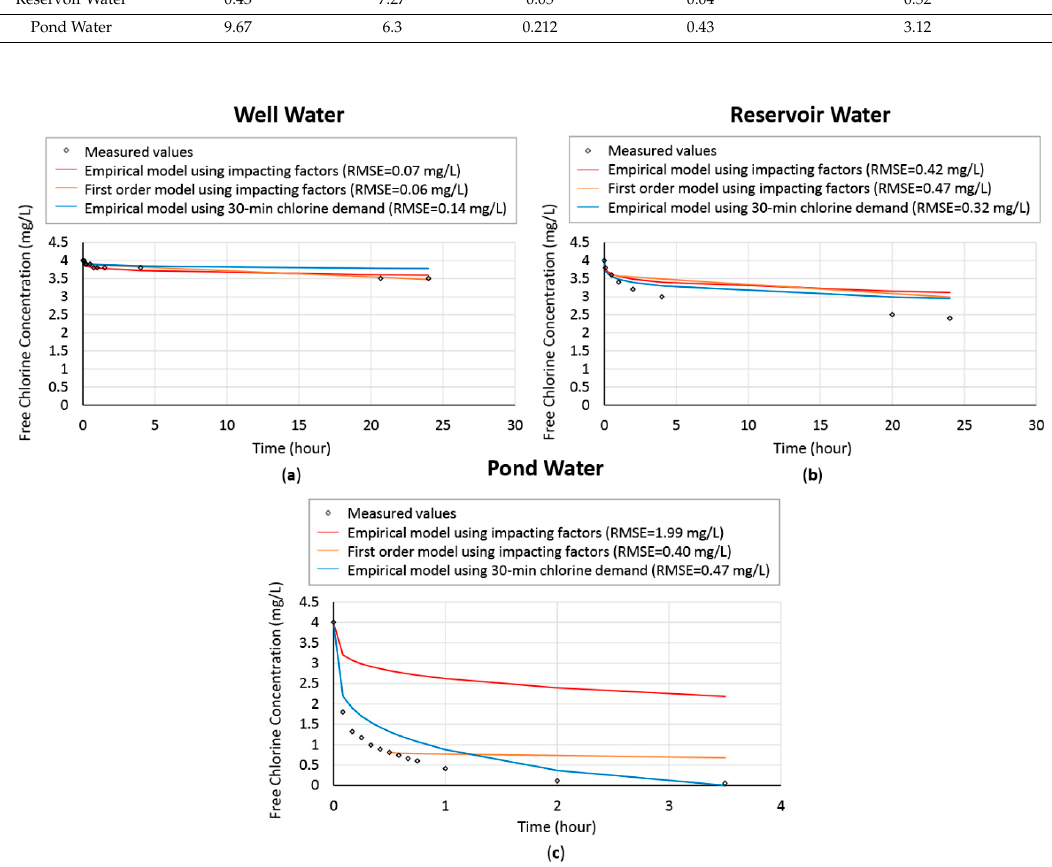
Figure 8. Predictions of chlorine decay in ( a ) well water, ( b ) reservoir water, and ( c ) pond water using the three developed models, and their comparisons with the measured values. The two models with different methods for model parameter calibration performed similarly in prediction of chlroine decay for well water. Feben and Taras’s empirical model with the decay constant calibrated based on water’s 30-min chlorine demand could best capture the trend of chlorine decay with a relatively small root mean square error value for both reservoir water and pond water.